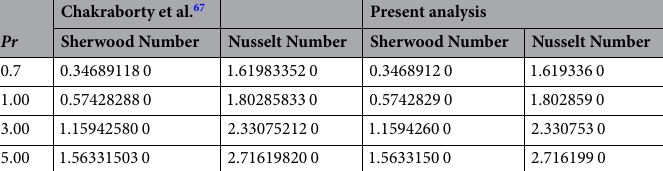
in Table 2. The magnitude of θ ′ ( 0 ) reduced and magnitude of φ ′ ( 0 ) increased by improving values of K 1 with fix